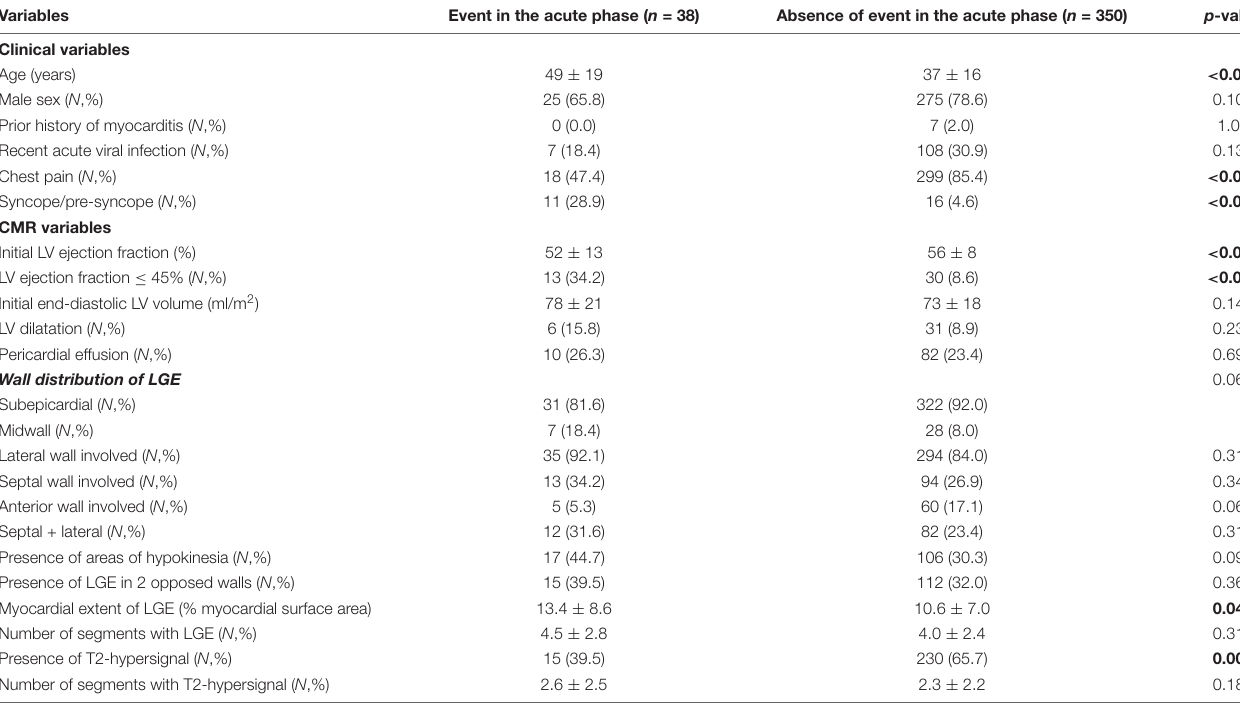
TABLE 3 | Patients with/without clinical event at the acute phase of AM. Variables Event in the acute phase ( n = 38) Absence of event in the acute phase ( n = 350) p -value Clinical variables